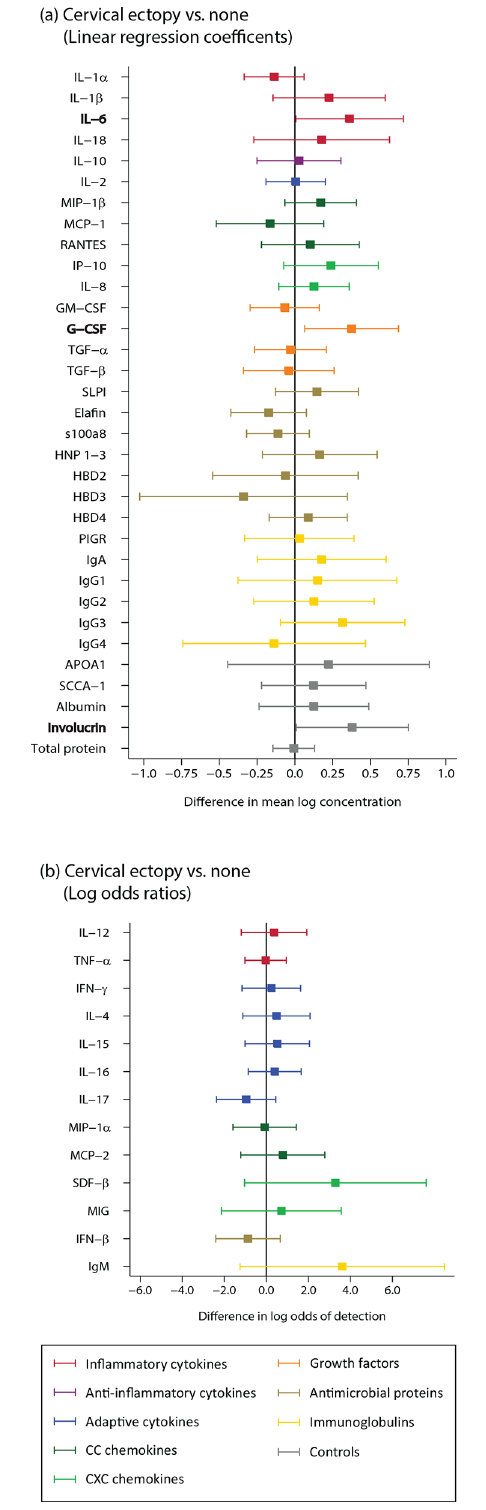
Fig 6. Clinical cervical ectopy (n = 67). Bolded analytes represent associations with a p-value (cid:1) 0.05. A comparison of analyte concentration between samples among women with cervical ectopy and women without ectopy (reference). (A) Analytes with > 85% detection using linear regression; (B) Analytes with < 85% detection using logistic